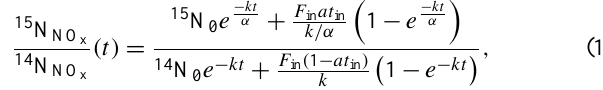
(substrate “pool”) (product “pool”) δ 15 NO − NO − , azide method 2 2 δ 15 NO − NO − , azide 3 2 2